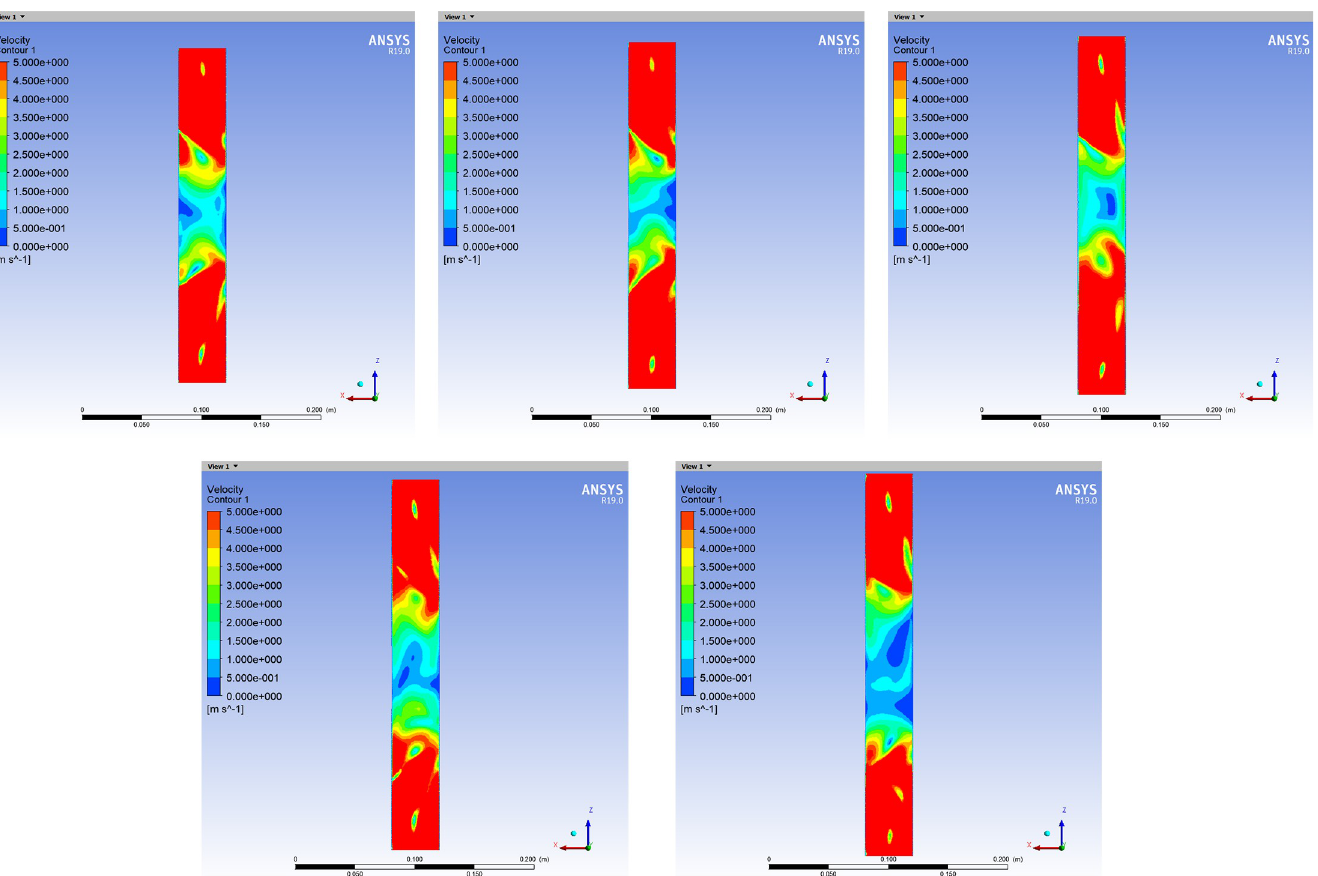
Fig 4. Wind velocity distribution inside the airflow tunnel when perpendicular to external wind vectors with different lengths. Results for airflow tunnel lengths of (A) 28 cm, (B) 29 cm, (C) 30 cm, (D) 31 cm, and (E) 32 cm.